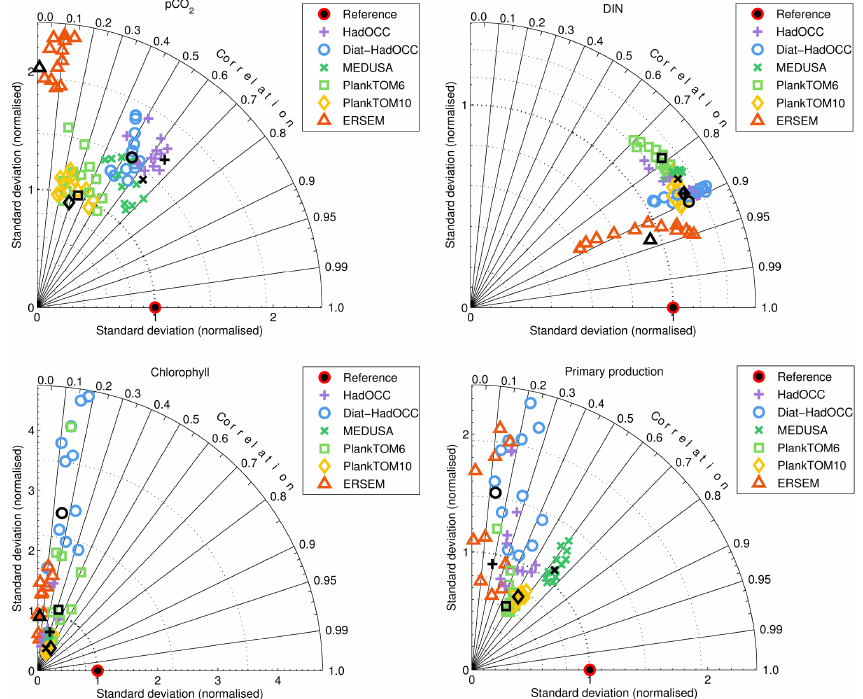
Figure 5. Monthly Taylor plots for p CO 2 , dissolved inorganic nitrogen (DIN), chlorophyll and primary production for all models relative to observations. Annual averages are shown in black. Note that negative correlation coefficients are not shown in the Taylor